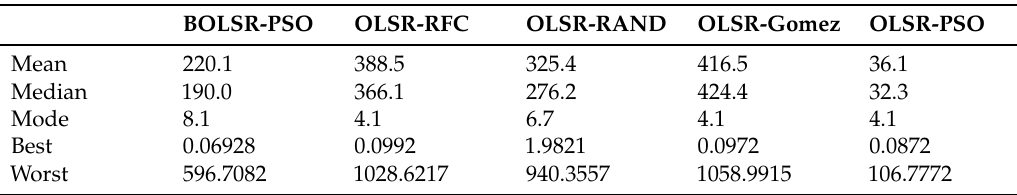
Table 7. Statistical Result of NRL Performance